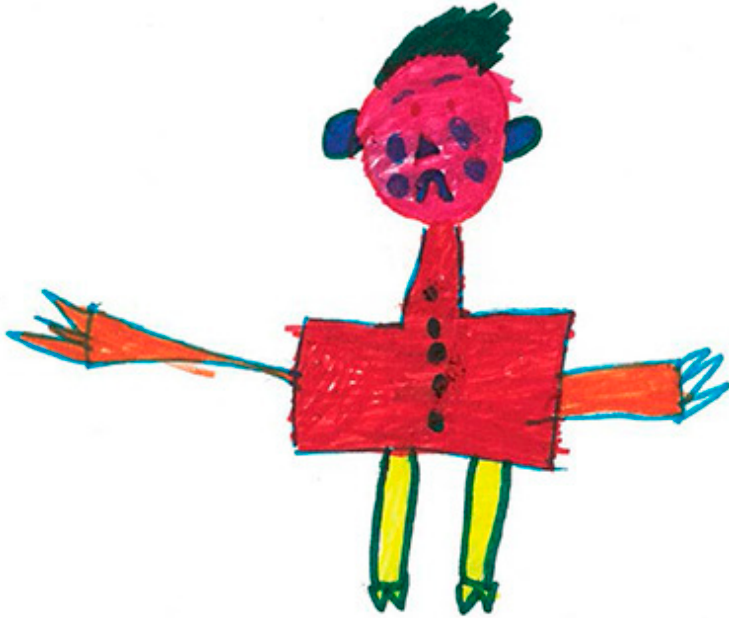
Figure 3. Drawing by primary school-age child, gender redacted, held at Christmas Island Detention Center. © Australian Human Rights Commission 2014. The Forgotten Children: National Inquiry into Children in Immigration Detention 2014 .